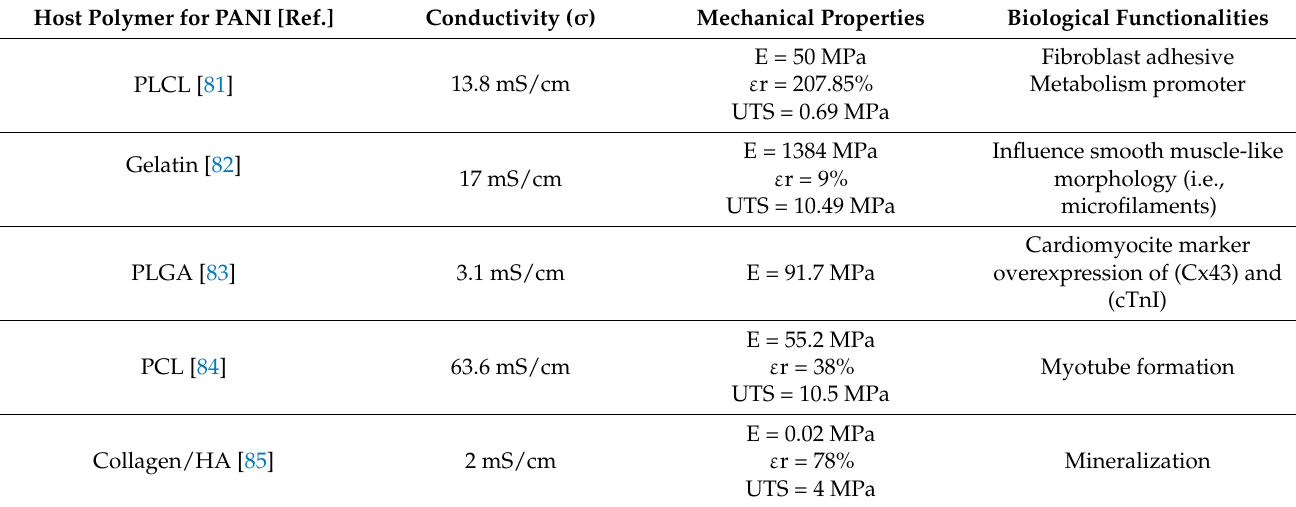
Table 2. PANI-based composites fibers as functional substrates for tissue engineering. Host Polymer for PANI